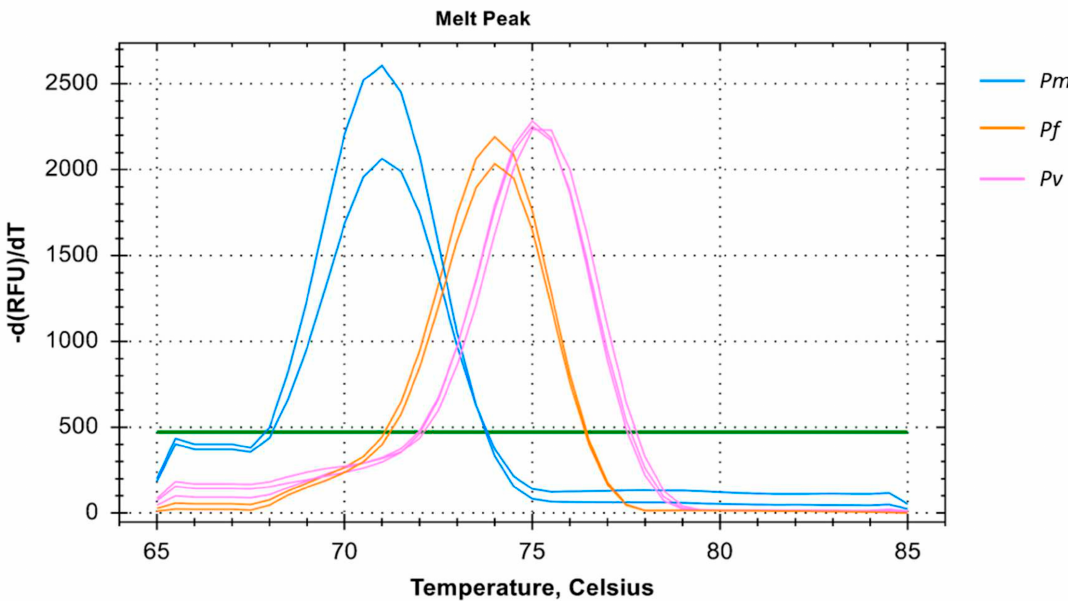
Figure 4. Melting curve analysis of Pm , Pf , and Pv samples in multiplex depicted by blue, orange, and pink colors respectively. The melting temperature (T m ) for Pm , Pf , and Pv of samples were 71 ◦ C, 74 ◦ C, and 75 ◦ C respectively. The multiplex melting curve analysis could only verify mono-infection with distinct melting temperatures for each